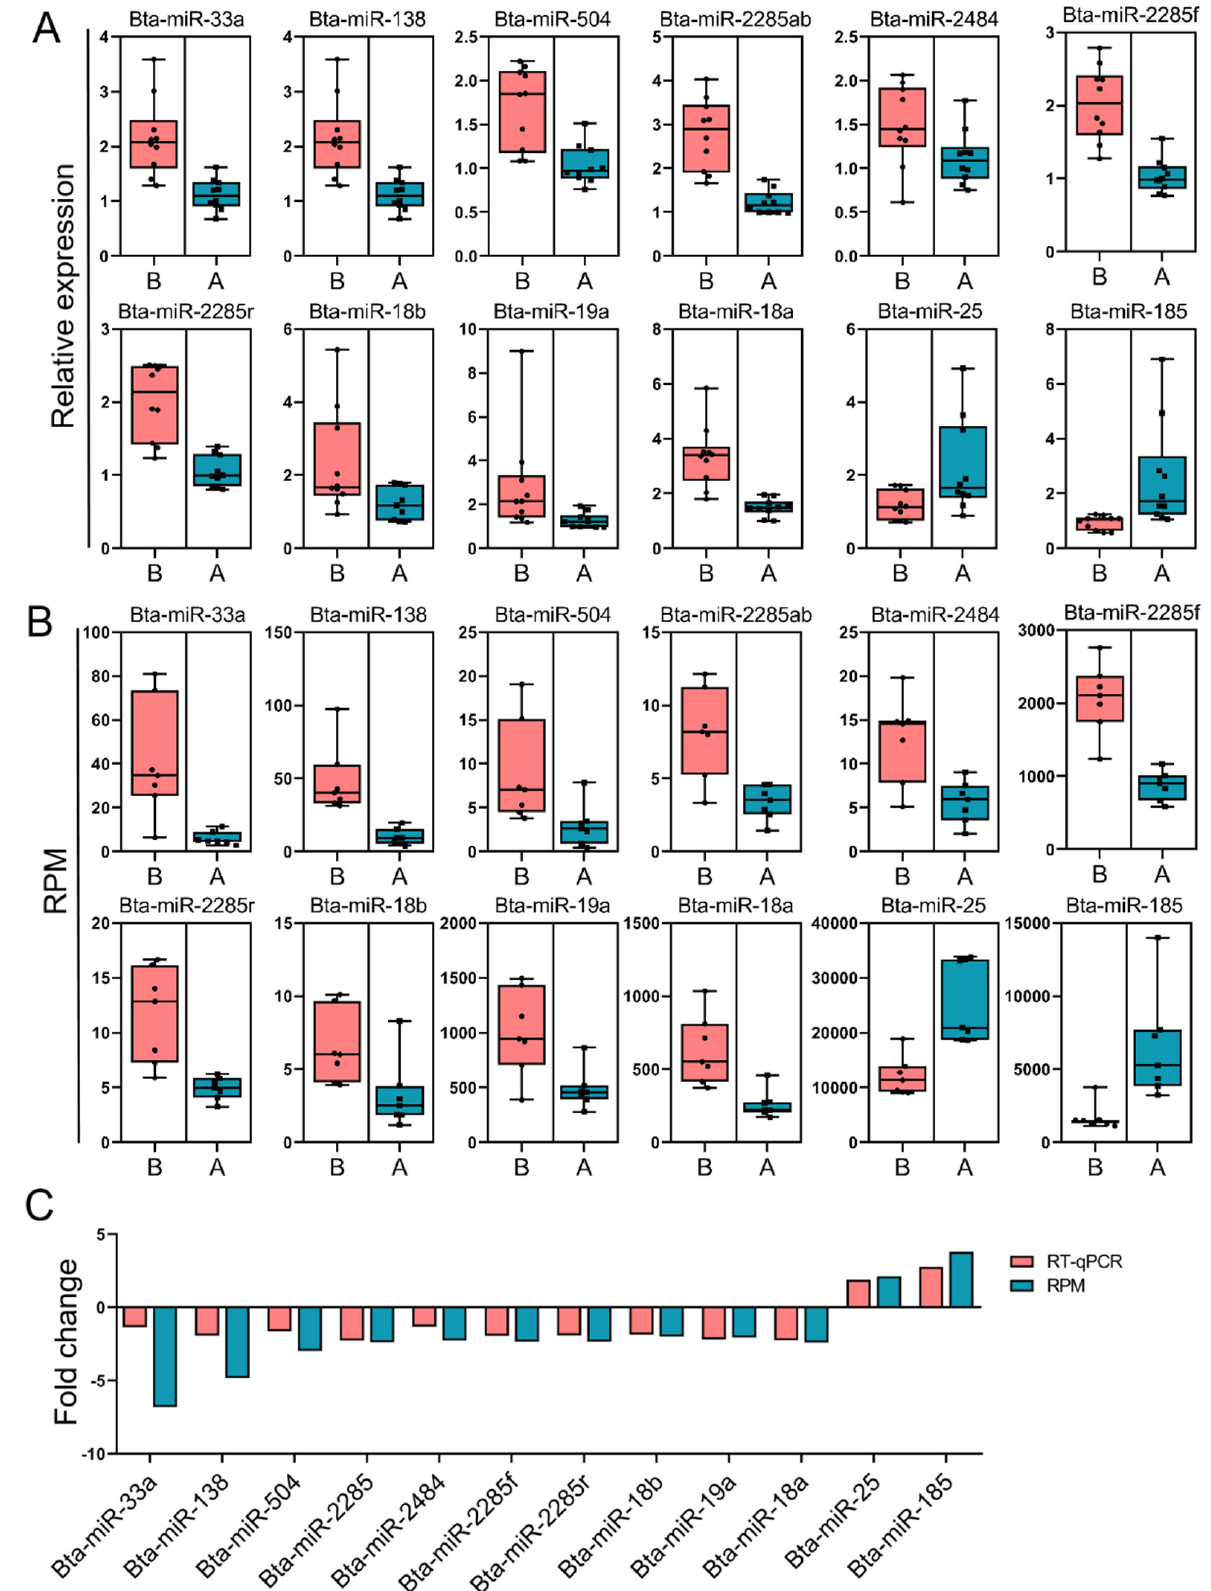
Figure 3. Verification of the differentially expressed miRNAs (DEMs) by PCR. ( A ) The relative expression levels of the selected DEMs by qPCR. ( B ) Log (transcript count per million [RPM]) of DEMs by RNA-seq. ( C ) Fold-change of DEM levels for both log (RPM) and qPCR.